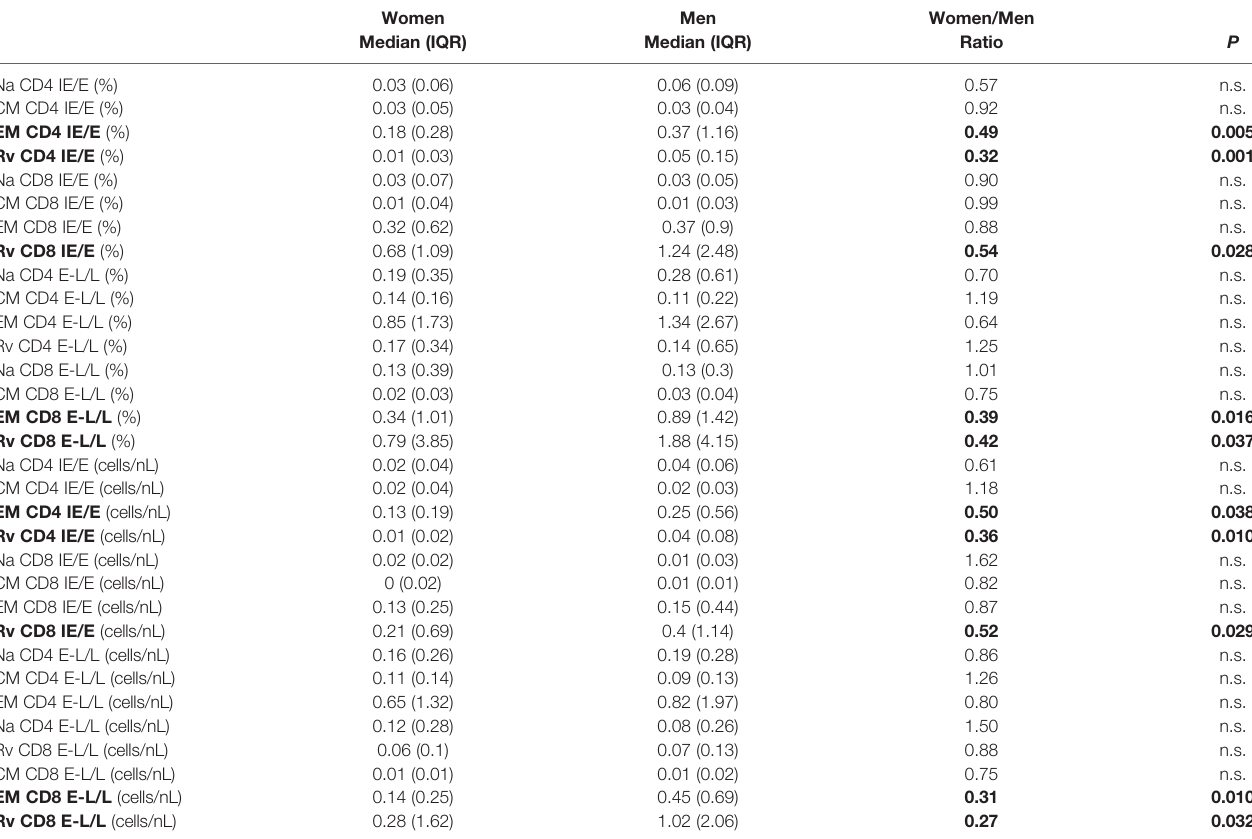
TABLE 3 | Biological sex differences in memory subset size and